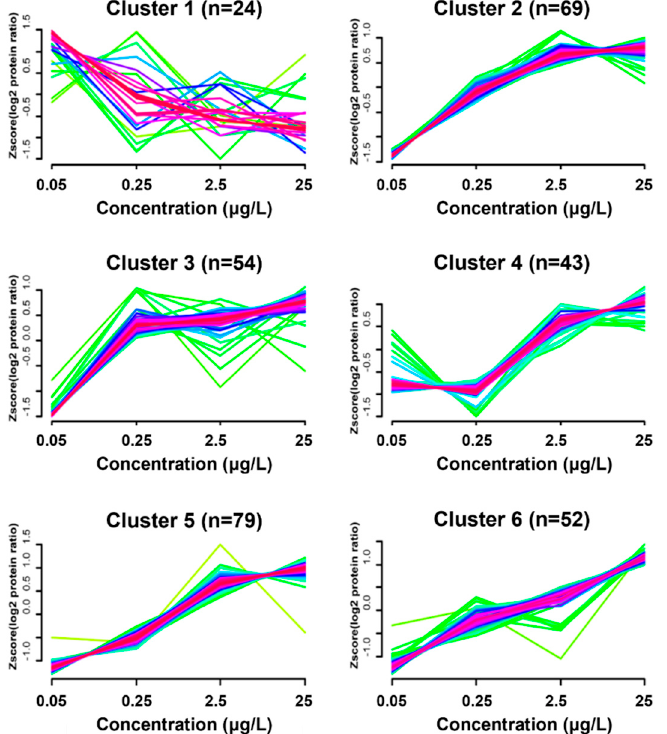
Figure 2. Dynamics clustering analysis of proteins quantified at 0.05 µ g/L organochlorine pesticide mixtures. (n = number of proteins included in each cluster).